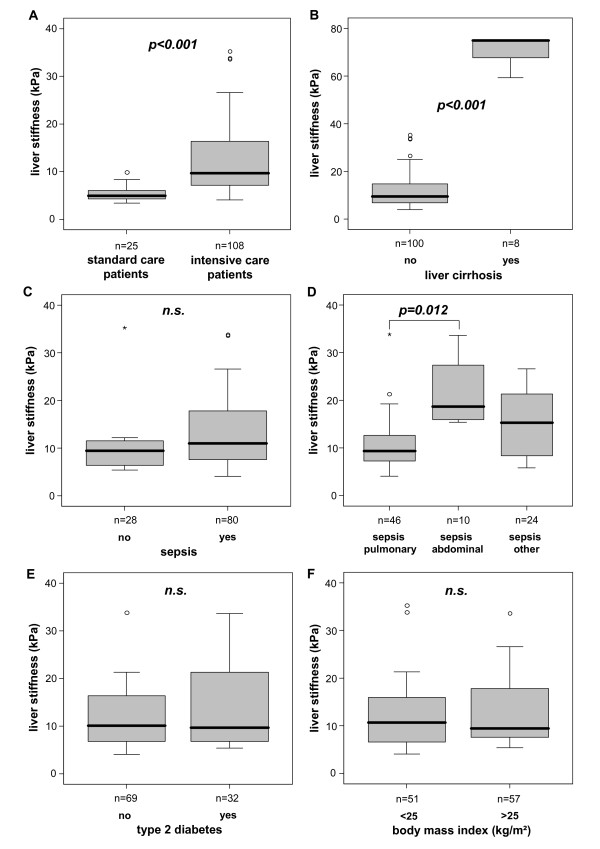
Liver stiffness in critically ill patients with different disease etiologies at ICU admission. (A) ICU patients have significantly higher liver stiffness values as compared with standard care (control) patients. (B) ICU patients with decompensated liver cirrhosis display highest stiffness values. (C) Liver stiffness does not differ between sepsis and non-sepsis patients. (D) In the subgroup of sepsis patients, patients with an abdominal site of infection show higher liver stiffness than patients with sepsis of pulmonary origin. (E-F) Pre-existing type 2 diabetes or obesity (BMI > 25 kg/m2) does not affect liver stiffness in ICU patients. P-values from U-test are given in the figure.